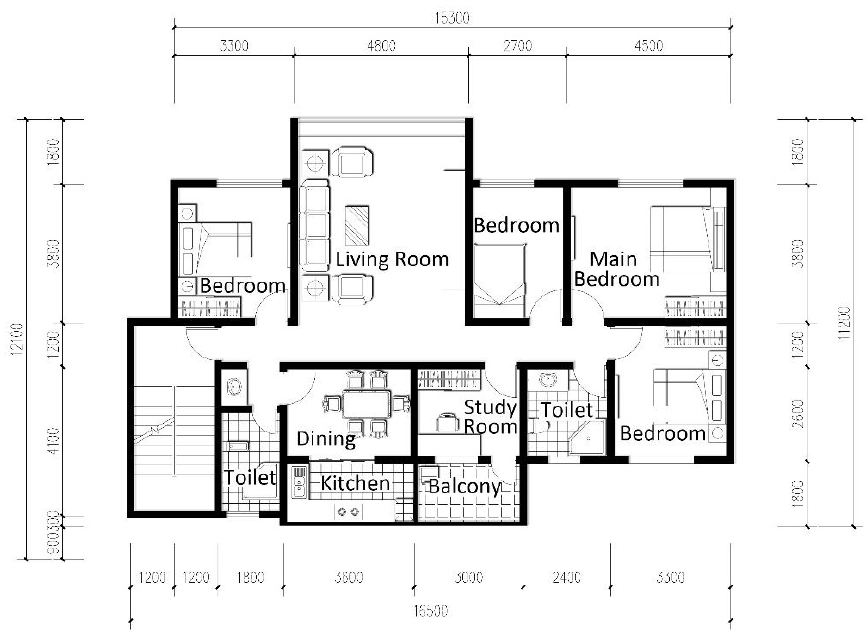
Figure 4. The plan of the apartment after modification.